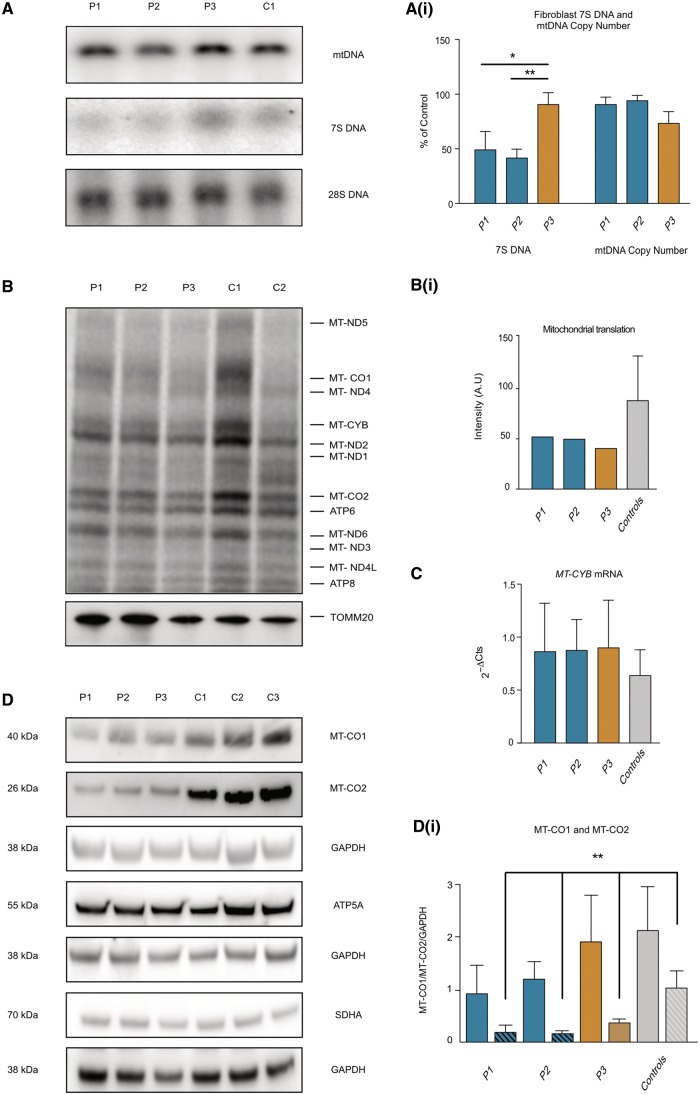

7S DNA, mtDNA copy number, intra-mitochondrial translation and mitochondrial gene expression. (A) Southern blot analysis of mtDNA copy number and 7S DNA levels in Subjects P1, P2, P3 and control fibroblasts. PvuII digested DNA was hybridized with a radiolabelled probe A (mtDNA position 16270–16292 and 389–369), which detects both genomic mtDNA and 7S. 28S was used as a loading control. [A(i)] Quantification of mtDNA and 7S DNA levels in Subjects P1, P2, P3 and control. 7S DNA levels normalized to genomic mtDNA levels, Subject P1 = 49.1 ± 16.7, Subject P2 = 41.6 ± 8.1, Subject P3 = 90.6 ± 10.8% of control. Mean ± SD of three independent experiments *P < 0.05, **P < 0.01 one-way ANOVA with post hoc Tukey test. Blood and fibroblast mtDNA levels assayed by qPCR targeting MT-ND1 and B2M detects no difference between Subjects P1, P2, P3 and controls (n = 3). Data represent mean ± SD of three biological replicates (blood data not shown). (B) Intra-mitochondrial protein translation analysis by incorporation of 35S methionine reveals a clear reduction of mitochondrial protein synthesis in Subjects P1, P2 and P3 compared to controls. Representative of three independent experiments. The characteristic bands of mitochondrial encoded proteins are annotated (MT-ND1, MT-ND2, MT-ND3, MT-ND4L, MT-ND5, MT-ND6: NADH dehydrogenase subunit 1,2,3,4L,5,6; MT-CO1, MT-CO2: mitochondrially encoded cytochrome c oxidase, I, II; MT-CYB: mitochondrially encoded cytochrome b; ATP6, ATP8: mitochondrially encoded ATP synthase 6,8). Loading determined by TOMM20 western blot. [B(i)] Quantification of band intensities from B. (C) Quantitative PCR analysis reveals no difference in MT-CYB mRNA levels between Subjects P1, P2, P3 and controls. Data represent mean ± SD of three biological replicates. (D) Representative western blot analysis of fibroblast cell lysates from Subjects P1, P2, P3 and controls reveals reduced steady state levels of MT-CO1 and MT-CO2 without change in nuclear encoded mitochondrial proteins ATP5A (ATP synthase subunit alpha) and SDHA (succinate dehydrogenase complex flavoprotein subunit A). [D(i)] Quantification of MT-CO1 (solid bars) and MT-CO2 (hashed bars) reveals a trend towards reduced MT-CO1 in Subjects P1 and P2 and significantly reduced MT-CO2 in Subjects P1, P2 and P3 compared to controls. Data represent mean ± SD of three independent experiments, **P < 0.01, one-way ANOVA with post hoc Tukey test.